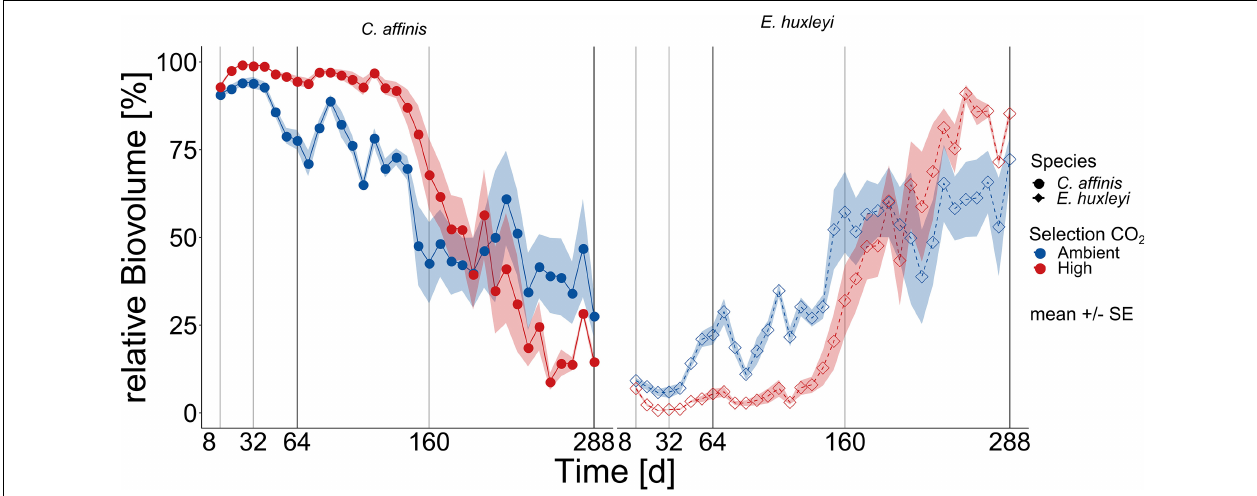
FIGURE 2 | Community biovolume composition over time. The relative contribution based on biovolume of E. huxleyi and C. affinis (right and left panel, respectively) measured at the end of each batch cycle over 36 batch cycles in the mix cultures (i.e., co-occurrence of both species) in ambient and high CO 2 is shown here (mean ± SE; n = 5 for days 1–200, and n = 4 for days 200–288 per time point). The light and dark gray lines show the time points where samples were taken for genotype reisolation. The dark gray lines show when the cultures were additionally tested for adaptation in the reciprocal assay.